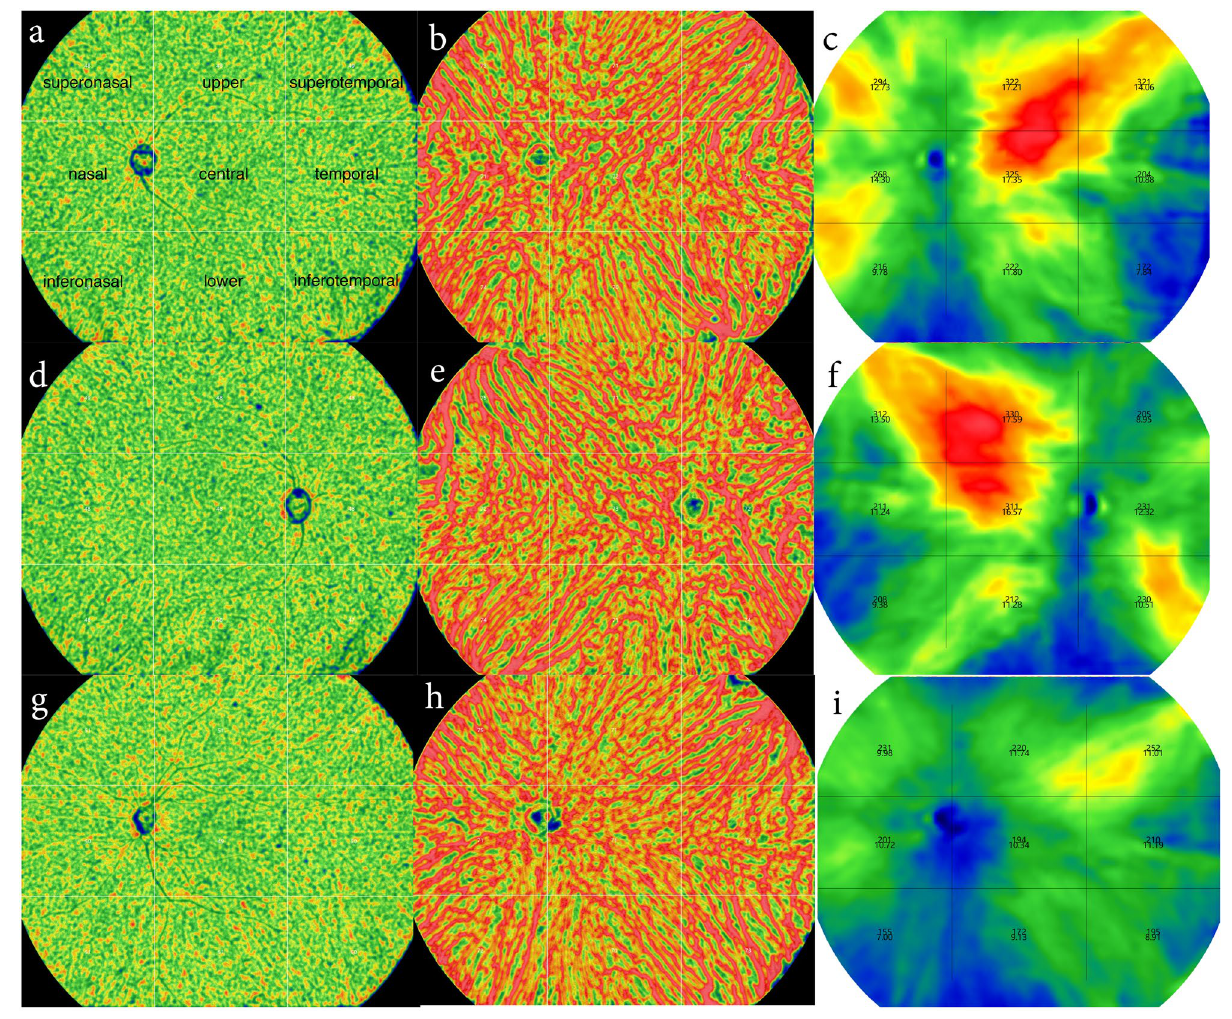
Figure 1. Representative maps of choriocapillaris density ( a , d , g ), large-vessel choroidal layer density ( b , e , h ), choroidal thickness, choroidal vessel volume ( c , f , i ) in CSC ( a – c ), fellow ( d – f ) and control ( g – i ) µm, P = 0.001), inferotemporal (266.1 ± 91.7 µm vs 229.9 ± 56.1 µm, P = 0.037) and inferonasal (166.8 ± 44.3 µm vs 148.4 ± 35.9 µm, P = 0.027) subfields of the measurement grid. The choroidal thicknesses of eyes with CSC, with the exception of the inferotemporal and superonasal subfields, were significantly greater than those of fellow eyes. Compared with the choroidal volume of normal eyes, those of eyes with CSC were significantly greater in superotemporal, upper, superonasal, temporal, central, nasal subfields. The choroidal volume of superotempo- ral, upper, temporal, central, nasal, lower and inferonasal subfields was greater in CSC eyes than in fellow eyes. Compared with control eyes, the density of choriocapillaris in the supertemporal (47.1 ± 1.9% vs 45.7 ± 3.1%, P = 0.006), inferotemporal (48.1 ± 1.5% vs 45.5 ± 4.0%, P = 0.007) and inferonasal (47.2 ± 1.8% vs 45.2 ± 3.1%, P = 0.002) subfields respectively was greater in eyes with CSC. Table 4 indicated that the choriocapillaris density in central subfield was similar to that in extra-central subfield in normal eyes (45.6 ± 1.1% vs 46.2 ± 1.8%, P = 0.057), while in the CSC (46.0 ± 1.1% vs 47.0 ± 1.1%, P < 0.001) and fellow eyes (45.7 ± 1.1% vs 46.8 ± 1.3%, P < 0.001), the choriocapillaris density in central subfield was less than that in extra-central subfield. There was positive correlation between choroidal thickness and choroidal volume in all the participants with correlation coefficients of more than 0.8 (P < 0.001). Choriocapillaris vessel density showed no correlations with large-choroidal vessel density in the three groups. Demographics of the acute CSC (aCSC) and chronic CSC (cCSC) patients were presented in Supplementary Table S1. cCSC presented with a significantly older year of age (43.3 ± 7.5 vs 50.3 ± 11.3, P = 0.014). Sex, and pro- portions of hypertension and diabetes were not different between the acute and chronic CSC. Comparisons of characteristics between acute and chronic CSC eyes were indicated in Supplementary Table S2. The IOP, AL and spherical equivalent did not differ between the two groups. However, the BCVA of patients with cCSC were sta- tistically worse (0.13 ± 0.15 vs 0.47 ± 0.53, P = 0.003). As shown in Supplementary Table S3, aCSC eyes presented with greater density of large-vessel choroidal layer in the upper (71.3 ± 1.9% vs 69.9 ± 2.5%, P = 0.034), superonasal (72.9 ± 1.8% vs 69.9 ± 4.5%, P = 0.002), temporal (71.9 ± 1.5% vs 70.1 ± 2.5%, P = 0.004), central (72.6 ± 2.0% vs 70.7 ± 3.4%, P = 0.017) and inferotemporal (72.0 ± 2.5% vs 69.3 ± 4.0%, P = 0.006) subfields. Compared with the